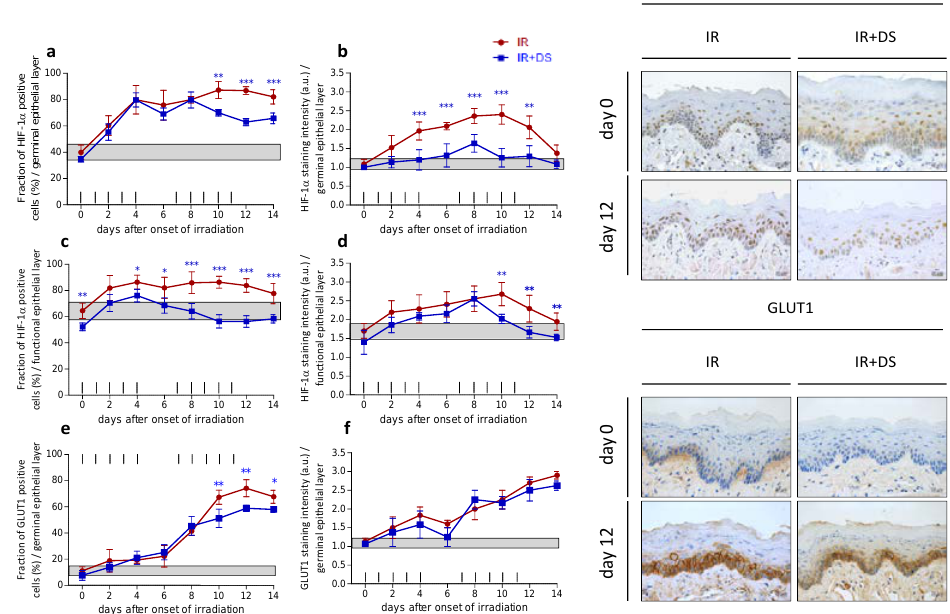
Figure 4. Effect of DS on irradiation-induced hypoxia. The relative number of HIF-1 α positive epithelial cells and their respective staining intensity were analyzed in the germinal ( a , b ) and functional compartments of the lower tongue epithelium, respectively ( c , d ); GLUT1 expression was limited to the germinal tissue layer ( e , f ). Data points represent the mean of 5 animals, error bars indicate ± 1 SD. The shaded areas illustrate the mean ( ± 1 SD) from 5 control animals. The fractionation protocol is indicated on top of the abscissae. Histophotographs illustrate representative HIF-1 α and GLUT1 staining on day 0 and after irradiation without and with DS treatment on day 12 of the study period. * p ≤ 0.05, ** p ≤ 0.01, *** p ≤ 0.001, Scale bar = 20 µm.